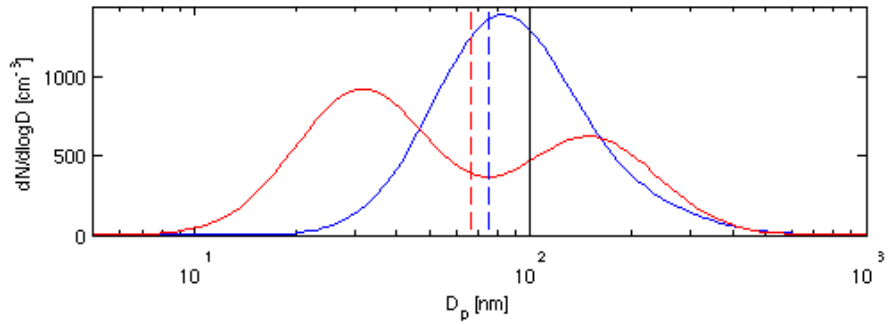
Figure 4: Schematic figure explaining the effects of reallocation to particle activation. Blue line is the emission mode, which is then reallocated into Aitken and accumulation modes (red curve). Dashed lines are the respective critical diameters for unrestricted and reallocating models and the solid black is the threshold diameter for Aitken mode. There is no background aerosol present.